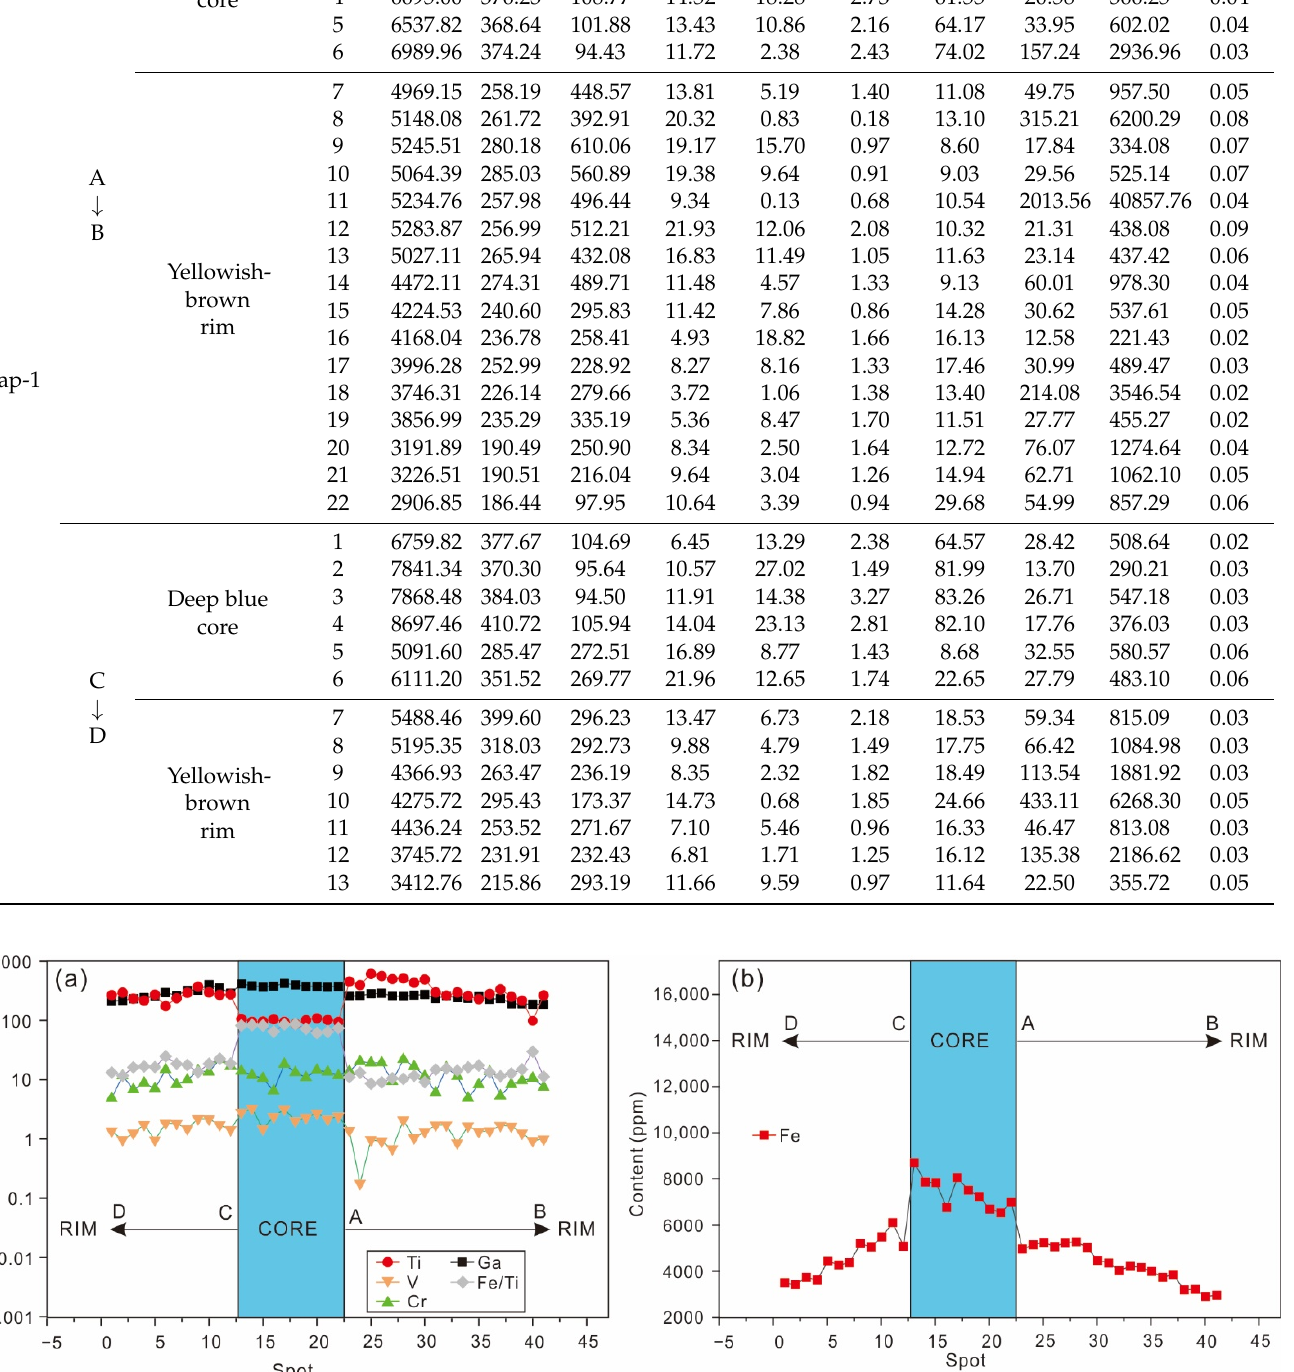
Figure 8. Compositional variations in trace elements of the Penglai sapphire over two profiles shown in Figure 4 from core to rim: ( a ) Distribution pattern of trace element contents of Ti, V, Cr, Ga and Fe/Ti ratio from core to rim; ( b ) Distribution pattern of Fe content from core to rim.